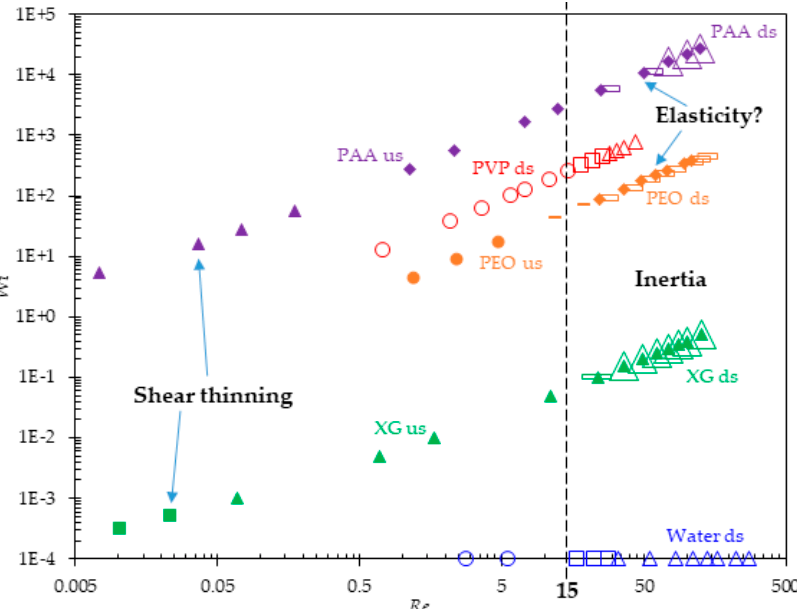
Figure 10. Summary of flow regimes in the Wi − Re space for the flow of Newtonian and non-Newtonian fluids through a contraction–expansion microchannel. Filled markers are for the upstream (us) flows at the contraction part and hollow markers are for the downstream (ds) flows at the expansion part of the microchannel: circles for no bending streamlines or vortices; squares for stable lip vortices; triangles for stable corner vortices; dashes for bending streamlines; diamonds for unstable or asymmetric corner vortices. The vertical dashed line indicates the Reynolds number, Re = 15, at which the fluid inertia starts drawing apparent disturbances to the flow at the expansion of the microchannel. Note that the Weissenberg number has been assumed to be 0.01 and 0.1 for the pure water and XG solution, respectively, for the purpose of the graph.